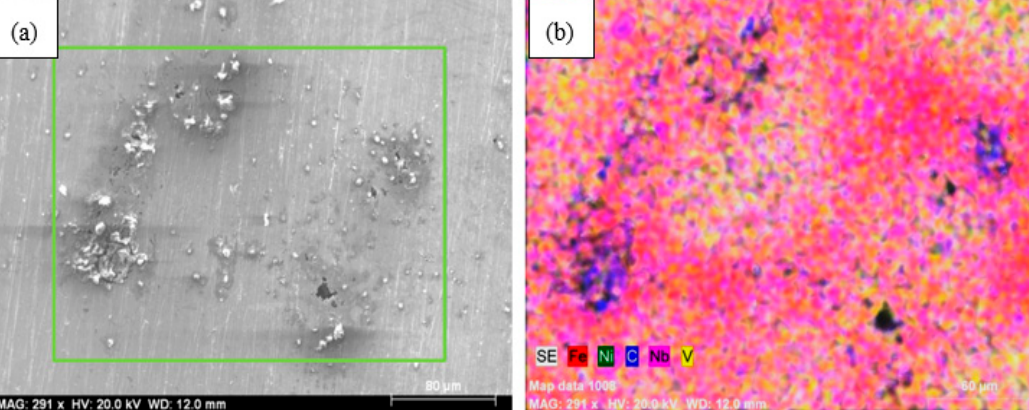
Figure 11. ( a ) SEM image and ( b ) mapping analysis of the alloy 9-NbV-40Ni after corrosion.